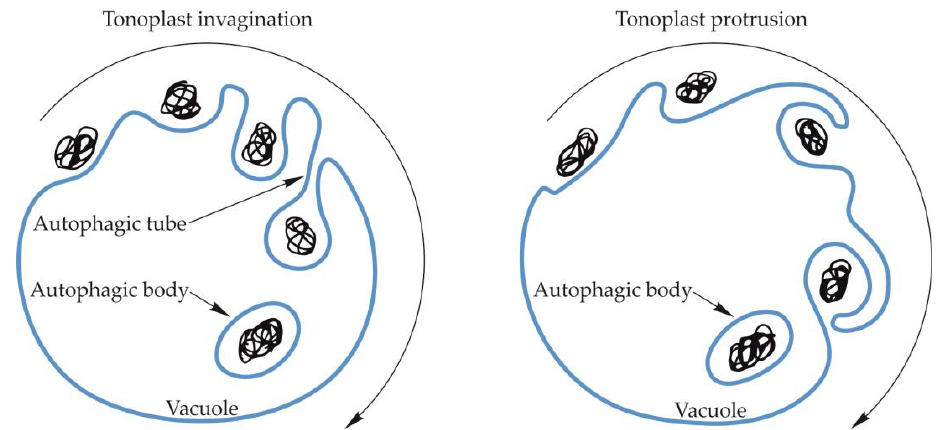
Figure 4. Schematic diagram of microautophagy in yeast and plants. Microautophagy may occur by vacuolar membrane invagination, which increases, creating the autophagic tube in yeast, and the cargo is enclosed inside the vacuole, forming a vesicle surrounded by a single two-layer membrane—an autophagic body. The occurrence of the autophagic tube in plants has not been confirmed. The autophagic body may also be formed by an arm-shaped protrusion of the tonoplast capturing a cargo into the vacuole.